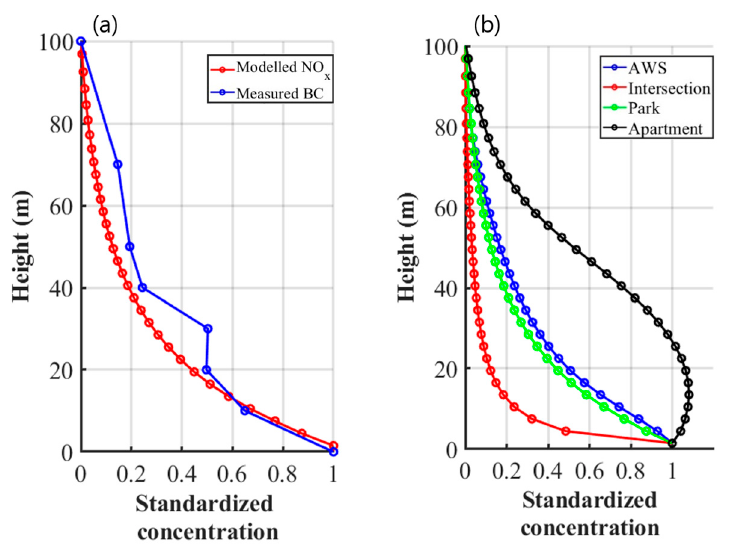
Figure 8. Standardized vertical profiles of ( a ) simulated NO x and measured BC concentrations at the drone measurement location and ( b ) simulated NO x concentrations at selected locations (i.e., AWS, Intersection, Park, and Apartment) around the road intersection.